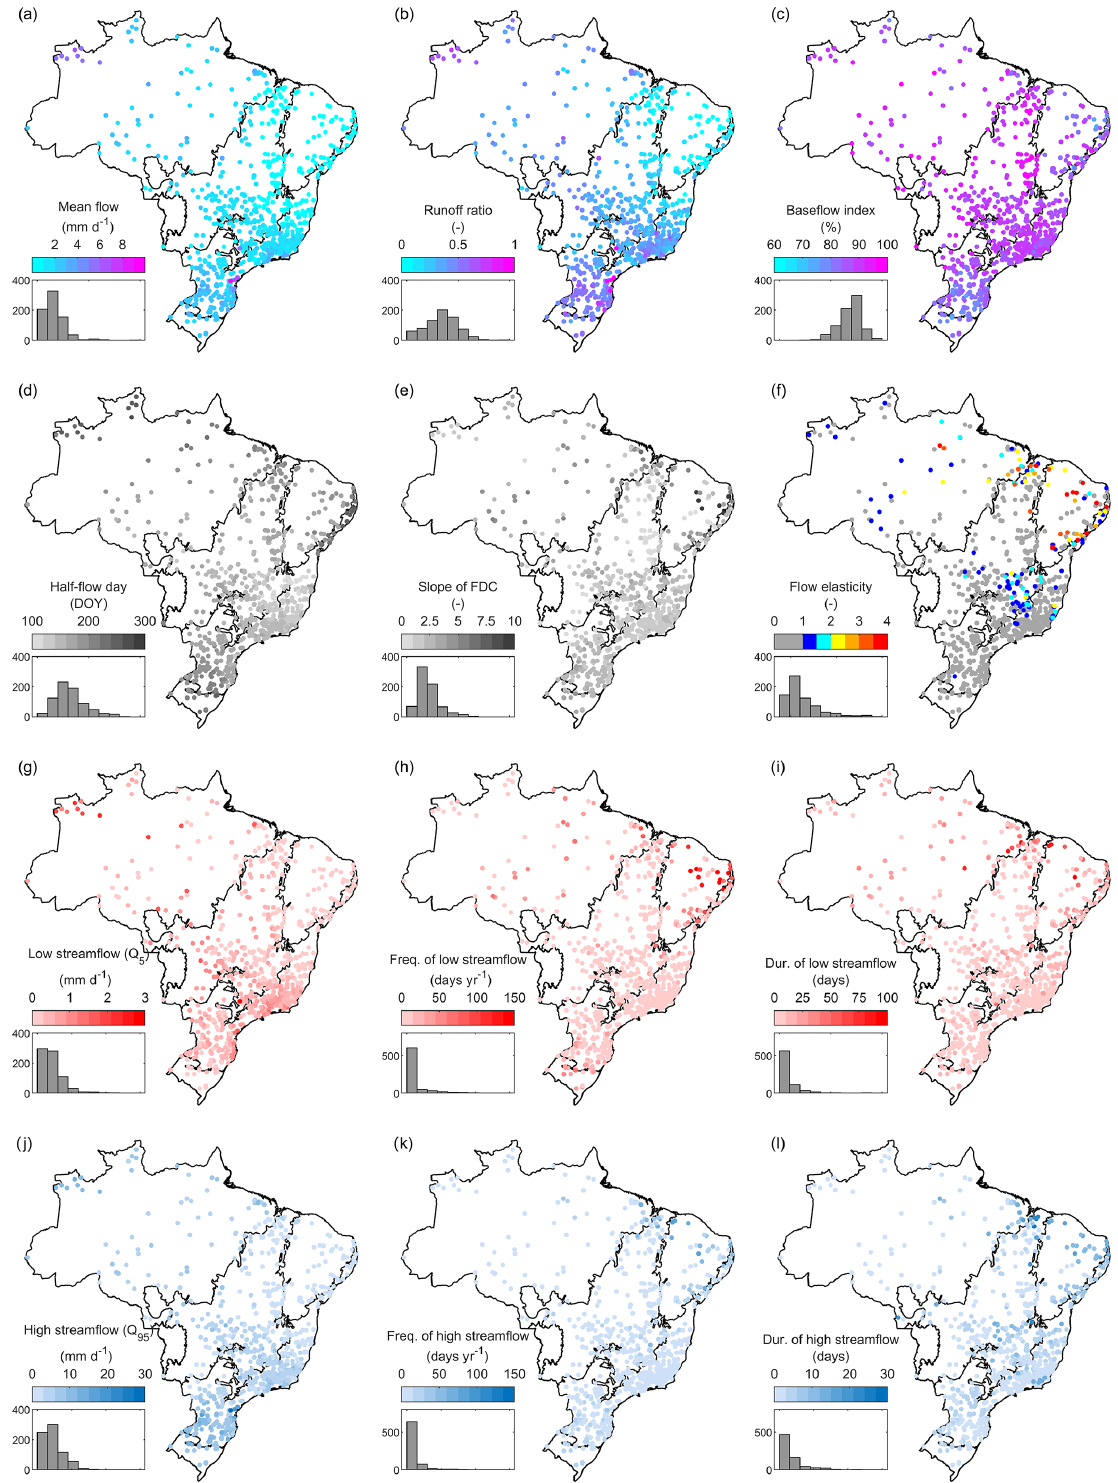
Figure 7. Spatial distribution of the hydrological signatures of the CABra catchments. (a) Mean daily streamflow (in mmd − 1 ); (b) runoff ratio (dimensionless); (c) baseflow index (dimensionless); (d) half-flow day (in day of the year); (e) the slope of the flow duration curve (dimensionless); (f) elasticity of daily streamflow (dimensionless); (g) low streamflow (in mmd − 1 ); (h) frequency of low-streamflow events (in dyr − 1 ); (i) duration of low-streamflow events (in d); (j) high streamflow (in mmd − 1 ); (k) frequency of high-streamflow events (in dyr − 1 ); (l) duration of high-streamflow events (in